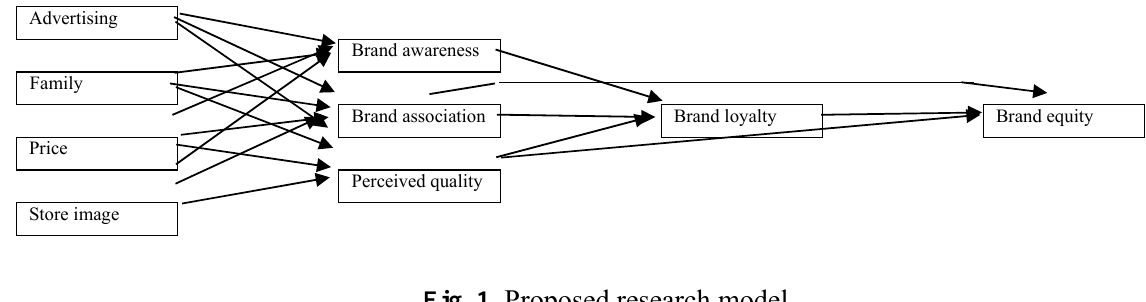
Fig. 1. Proposed research